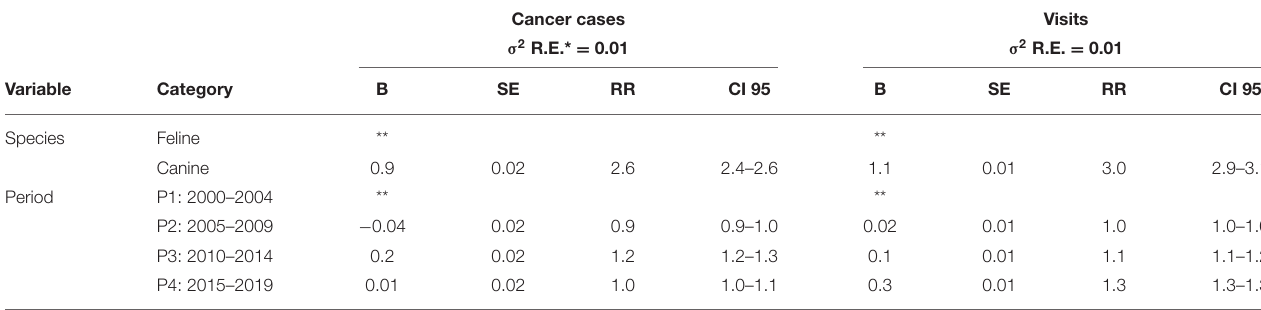
TABLE 1 | Results of the factors included in the Bayesian hierarchical models to determine the catchment area for cancer cases and visits. Cancer cases Visits σ 2 R.E.* =